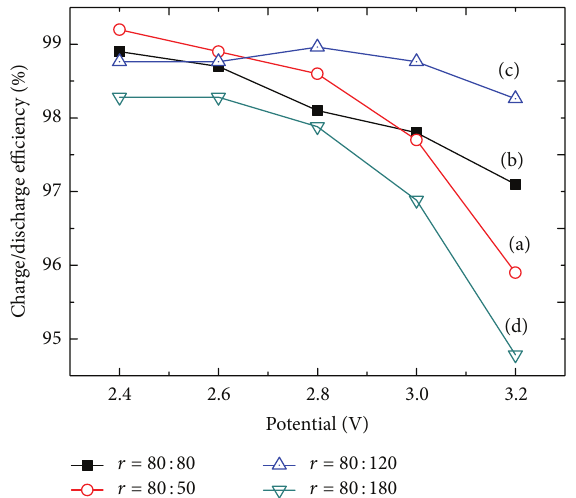
Figure 5: Charge-discharge efficiency cures of different potential. (a) 𝑟 = 80 : 50. (b) 𝑟 = 80 :80. (c) 𝑟 = 80 :120. (d) 𝑟 = 80